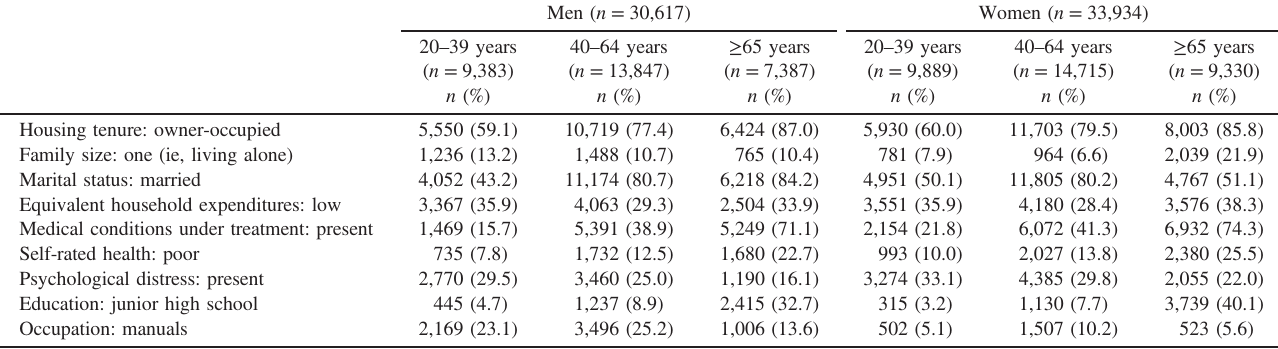
Table 1. Characteristics of analyzed participants by age and gender